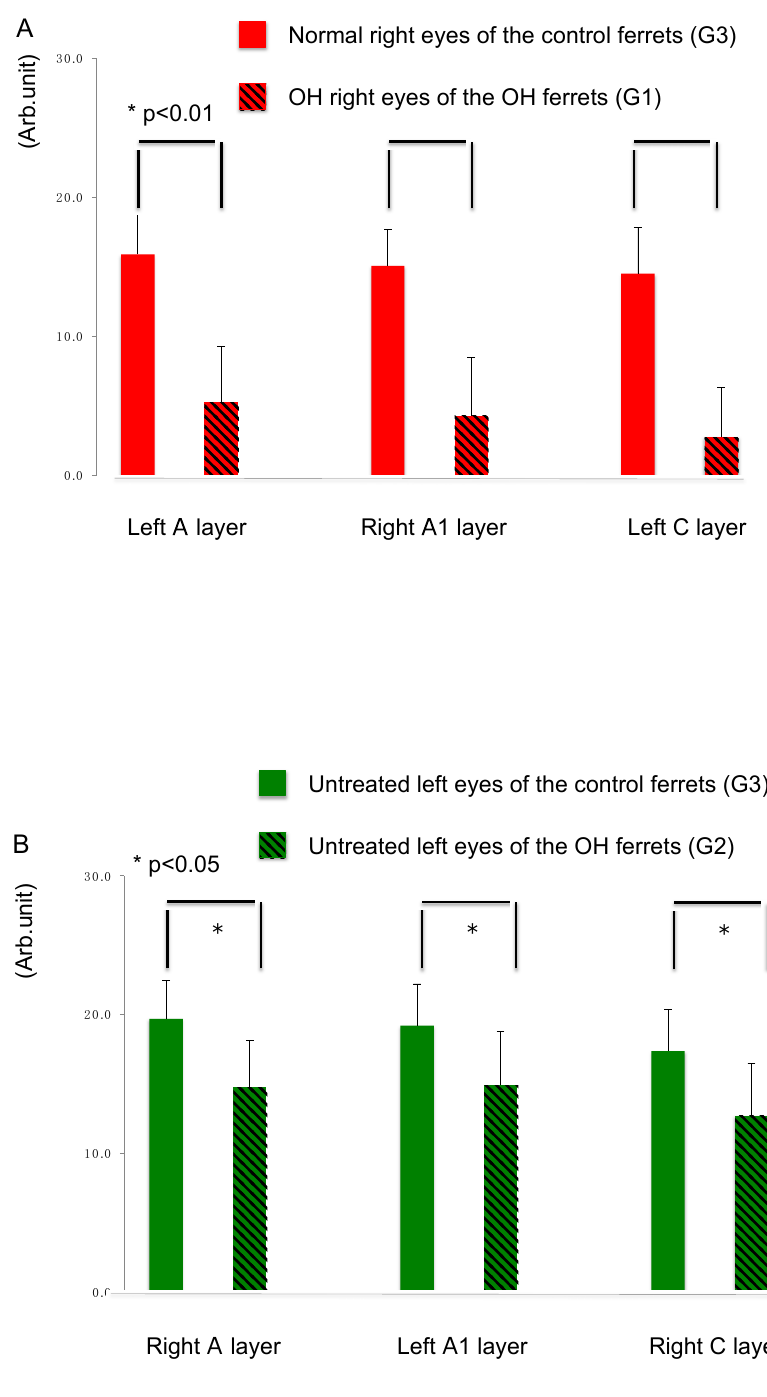
Figure 3. Comparison of axon damage in LGN layers of the OH ferret and the control ferret. ( A ): The immunointensity of CTB in each LGN layer projected from the OH right eyes (G1) of OH ferrets was significantly decreased than in corresponding LGN layers in the untreated right eyes of control ferrets (G3; n = 10, unpaired t -test, p < 0.01). ( B ): The immunointensity of CTB in each LGN layer projected from the contralateral untreated left eyes (G2) of OH ferrets was significantly decreased than in corresponding LGN layers in the untreated left eyes of control ferrets (G3; n = 10, unpaired t -test, p <